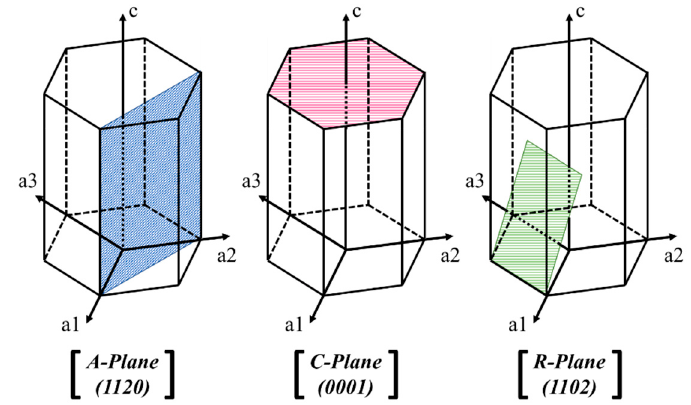
Figure 8. Crystal orientation of sapphire glass. Table 5. Literature values of thermal conductivity for sapphire glass.